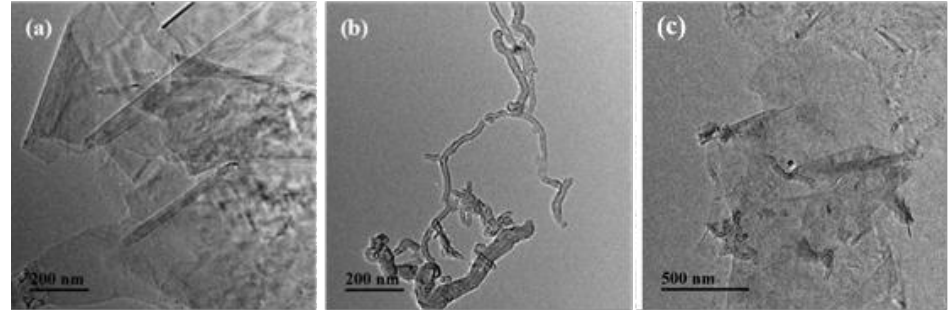
Figure 1. The transmission electron microscopy (TEM) images of ( a ) hydroxyl graphene nanoplatelets (GnPs-OH); ( b ) hydroxyl multi-walled carbon nanotubes (MWCNTs-OH); ( c ) hybrid